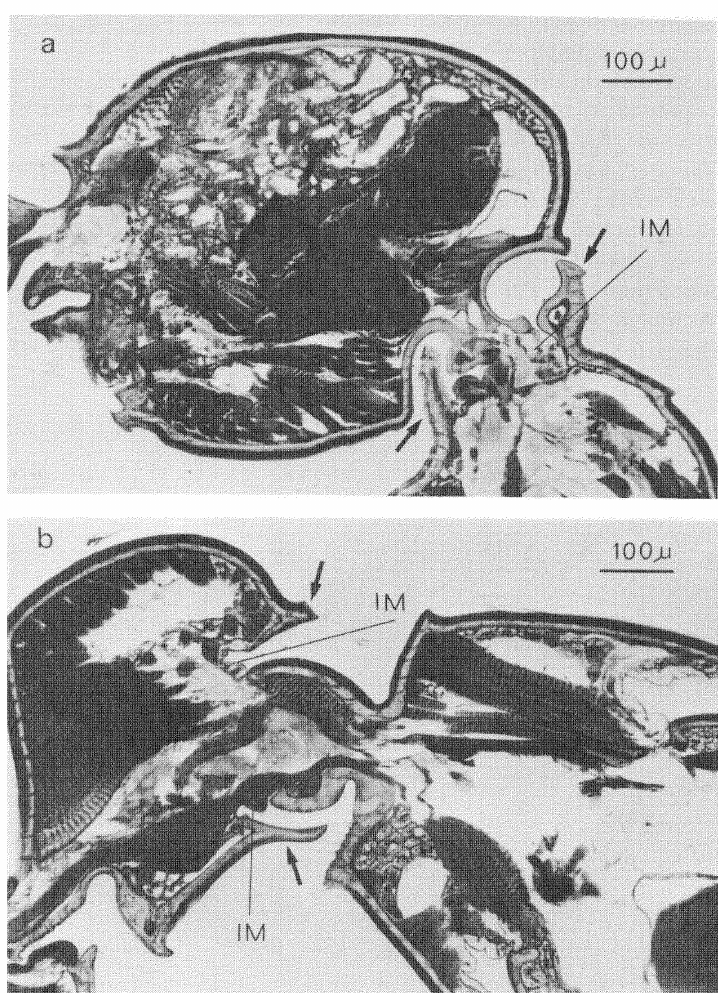
Figure 2. Longitudinal section through the head and part of the thorax (a) and through part of the petiolus and gaster (b) of a Cerapachys worker. Arrows indicate cuticle projections over intersegmental membranes